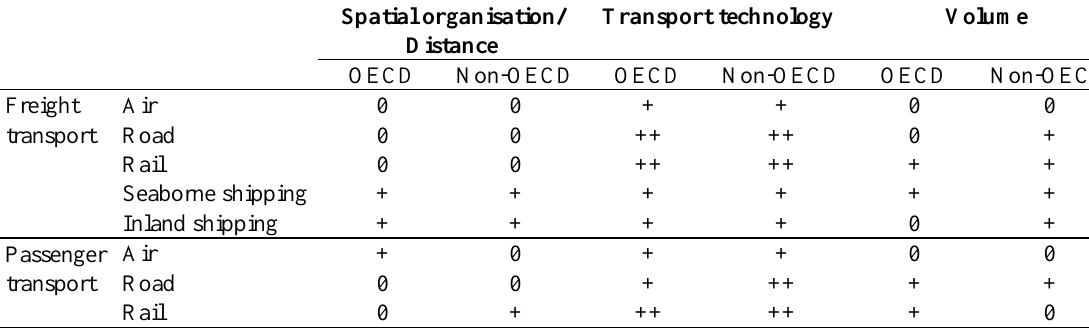
Table 4. Scenario 4: Global: Sustainable